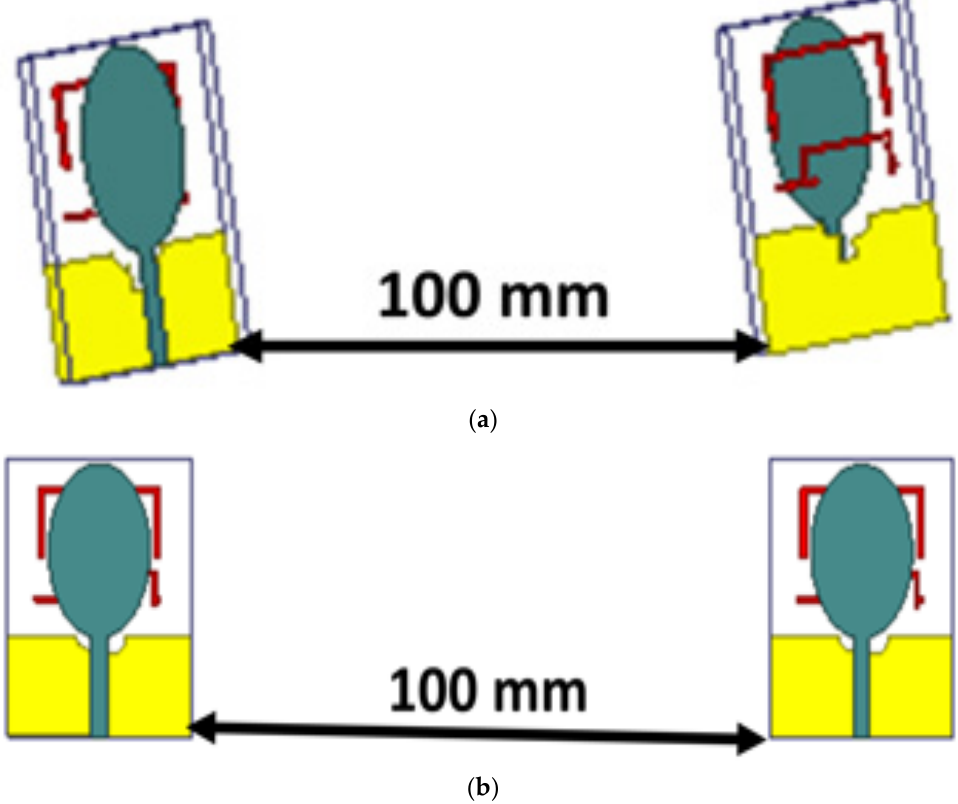
Figure 24. Time ‐ domain analysis with orientations, viz., ( a ) frontal and ( b ) lateral. Figure 24. Time-domain analysis with orientations, viz., ( a ) frontal and ( b )